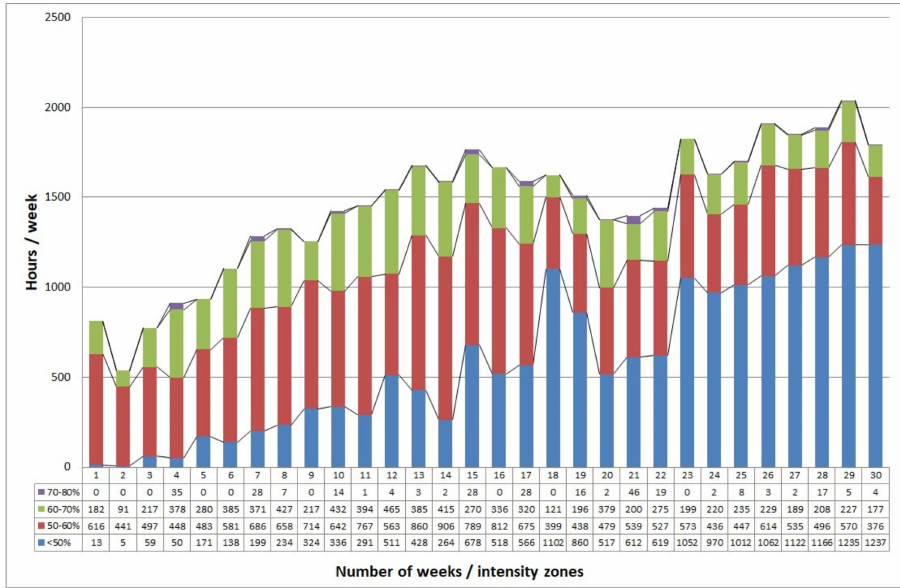
Figure 1. Training h/week spent in HR zones during the program. Maximum HR was determined from the 220-age formula, and intensity zones were calculated for the